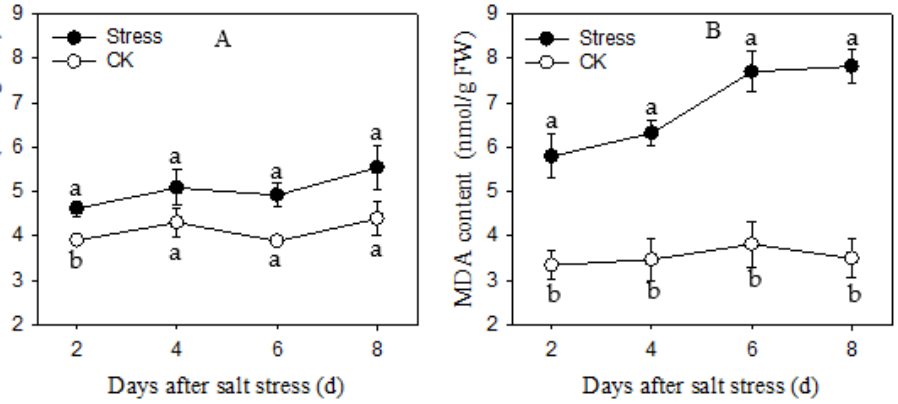
Figure 4. MDA content of two asparagus cultivars under salt stress. ( A ) is Apollo and ( B ) is JL 1.Different lowercase letters in the line graph indicate significantly different from the control at p < 0.05. CK meaning seedlings were watered by Hoagland solution without NaCl, and SS meaning seedlings were subjected to salt stress of 120 mM